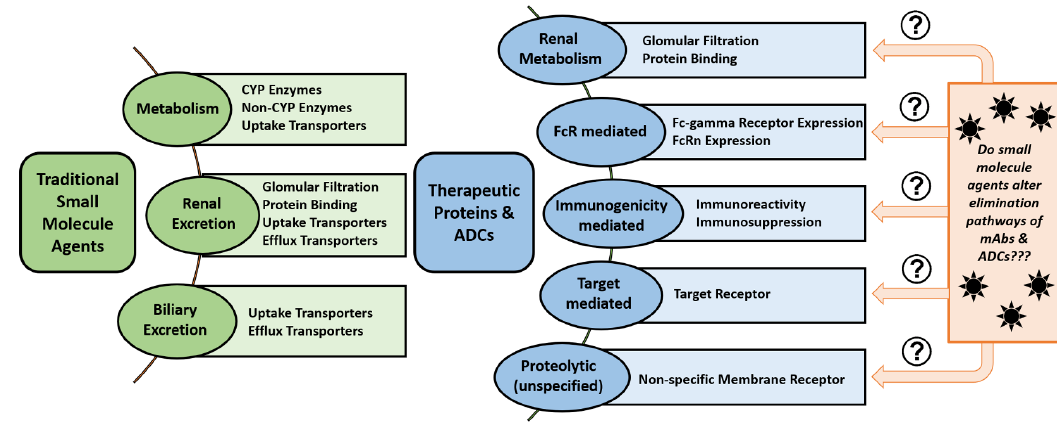
Figure 2. Differences in the metabolism and elimination of small molecules drugs compared to antibodies and antibody–drug conjugates